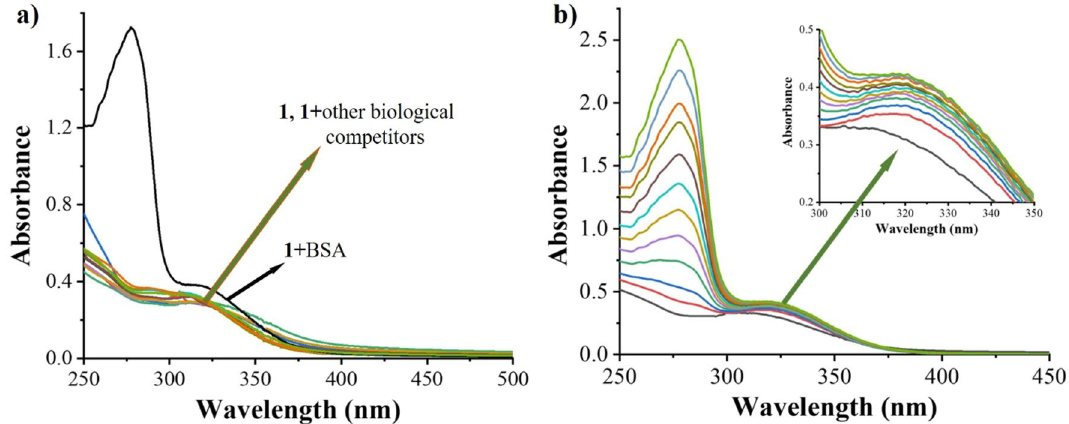
Figure 4. UV–vis absorption spectra of probe TPE-kana 1 (5 × 10 −5 M) in distilled water upon addition of ( a ) 120 nM of BSA, heparin, ascorbic acid, sodium pyro-phosphate, sodium oxalate, sodium citrate, adenosine triphosphate, glutamic acid, aspartic acid, sodium acetate and glucose. ( b ) Addition of the BSA (0–120 nM) in D/W.